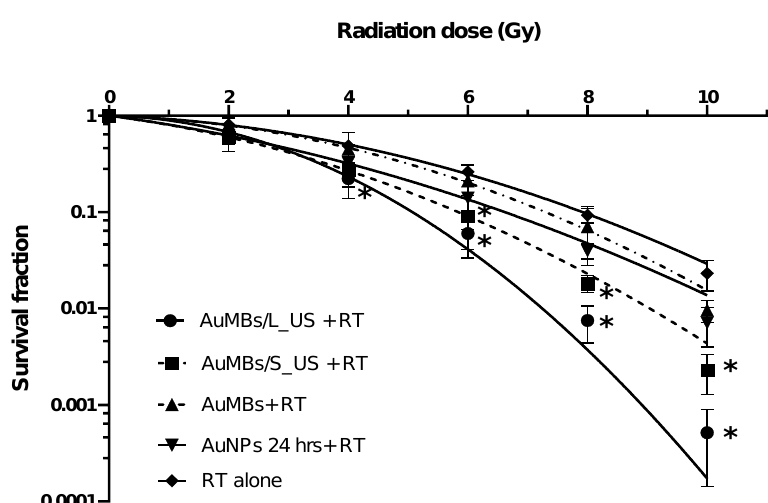
Figure 5. The numbers of colonies in each well containing more than 50 cells were counted as the quantitative results of the clonogenic assays. Data are mean and SD values from three independent experiments. * p < 0.05 compared with RT alone.